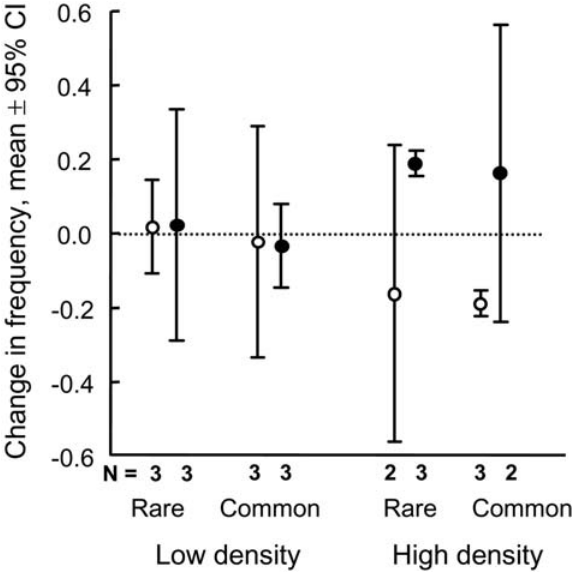
Figure 3. Change in frequencies of low and high RE tactics in the different treatment populations during the breeding season. Frequency of high RE tactics increased significantly when densities were high and initial frequency was low (rare tactic), which simultaneously decreased the frequency of low RE (common tactic). Open circles: low RE; Closed circle: high RE. N=number of replicates